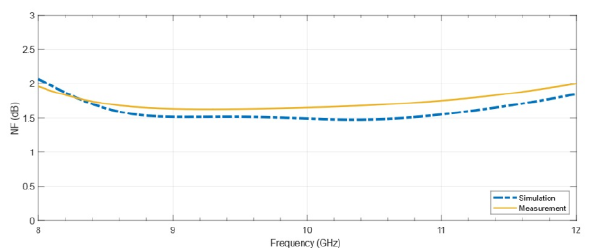
Figure 20: Noise figure results of the LNA. Dashed line simulation and solid line